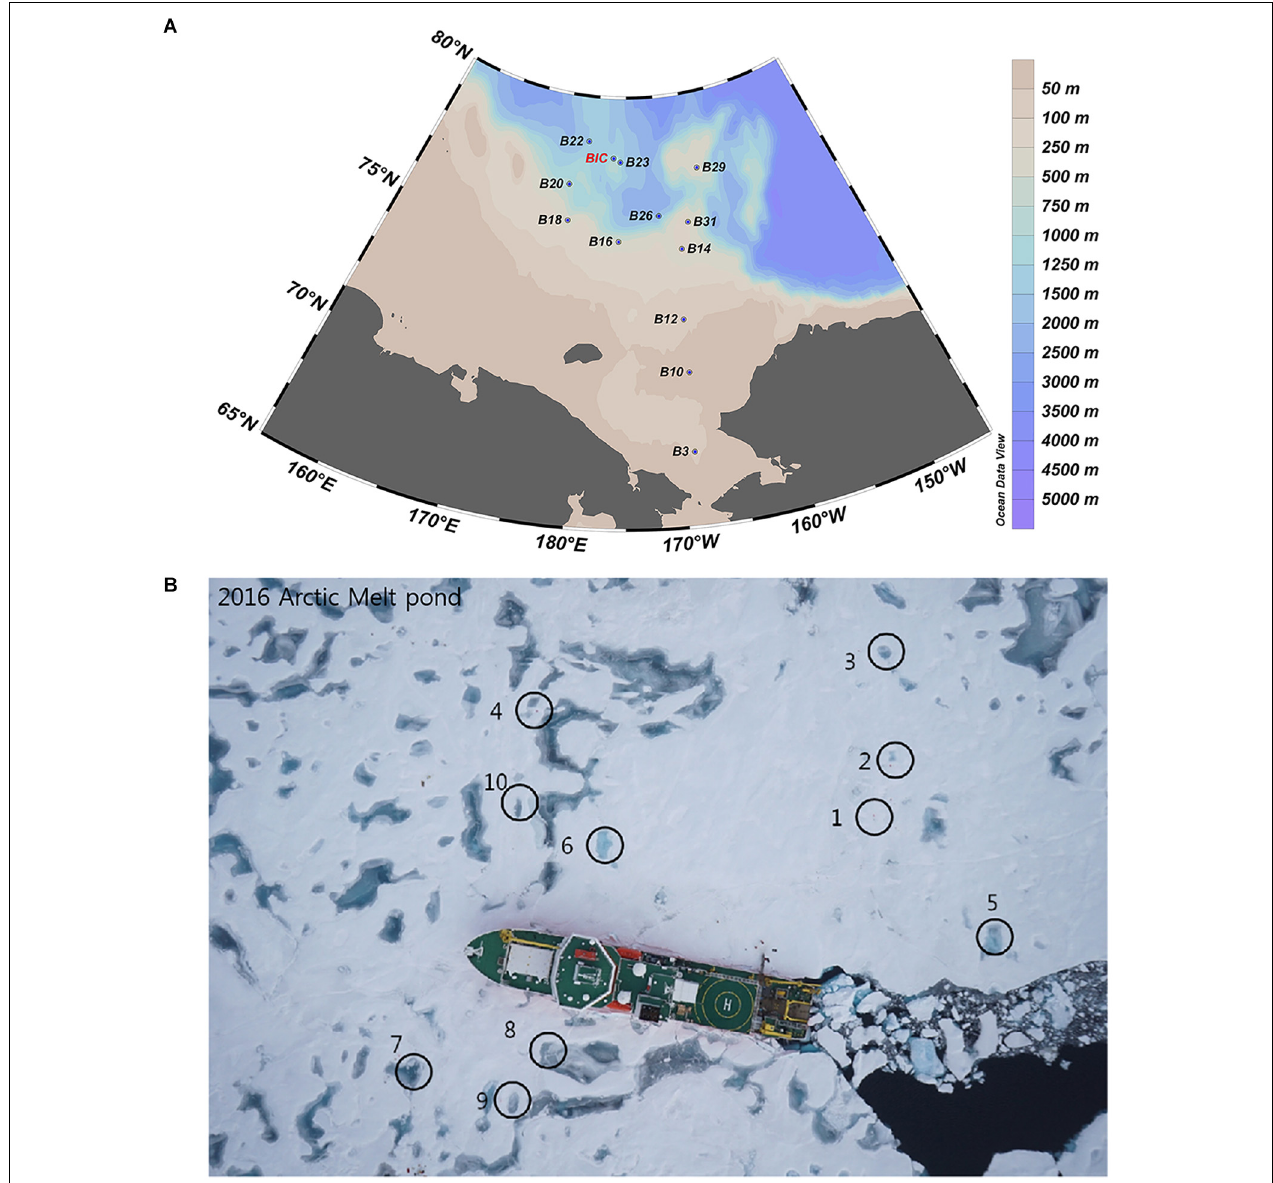
FIGURE 1 | Sampling sites in the Arctic Ocean during the summer cruise of ARA07 conducted in 2016, showing the sea water (A) and melt pond (B) sites, respectively.